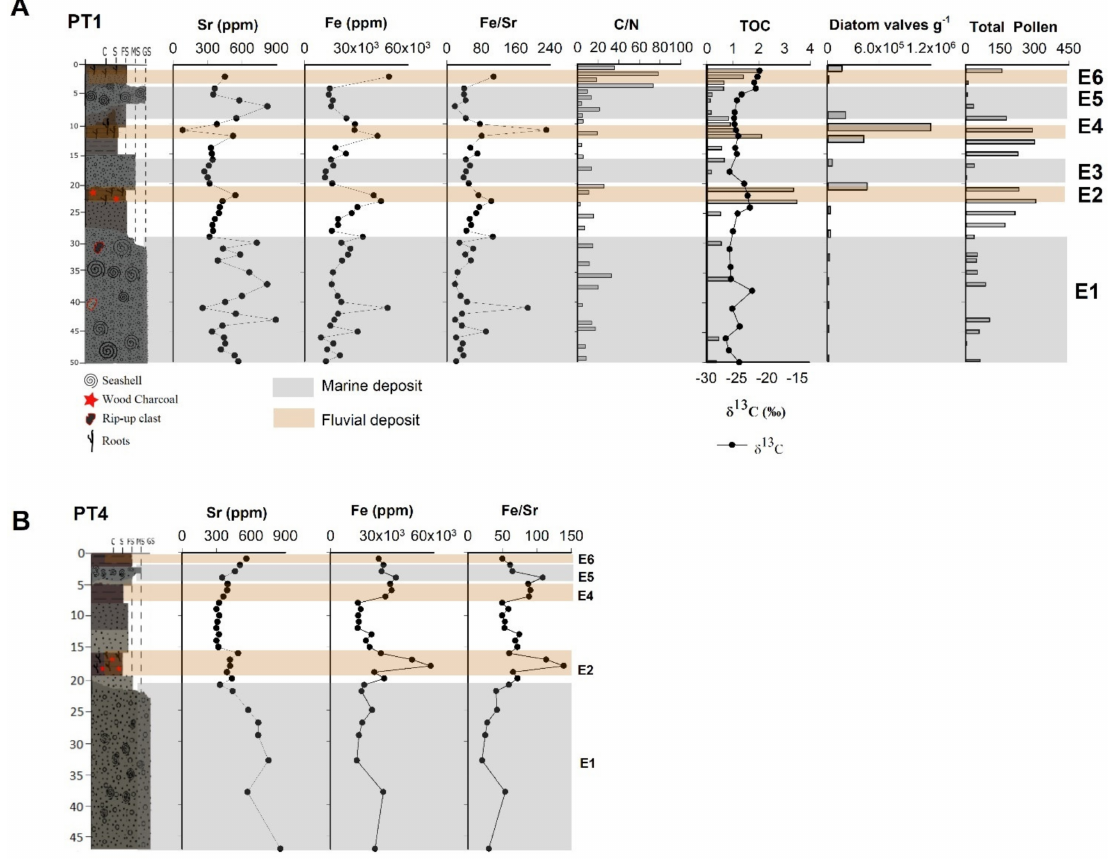
Figure 6. Biological l features of the PT1 ( A ) and PT4 ( B ) core; in gray, the deposits associated with thick granulometry; in brown, deposits associated with a fine grain size, related with marine (1, 3 and 5) and continental deposits (2, 4 and